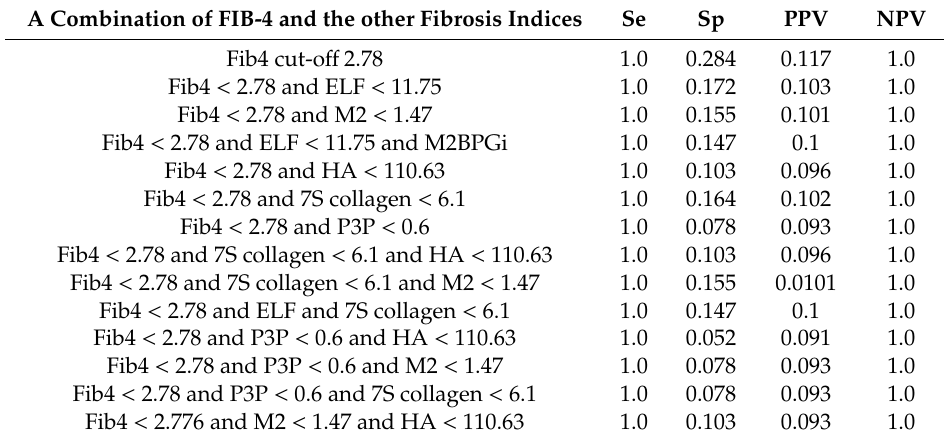
Table 4. Performance of a combination of FIB-4 and the other fibrosis indices for the prediction of high-risk varices in the estimation cohort ( n =